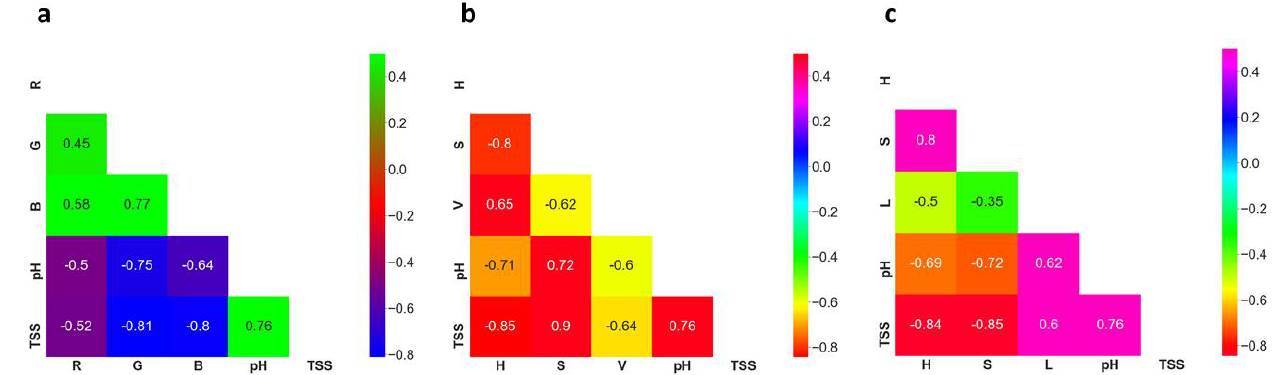
Figure 5. Pearson correlation coefficients for the relationship between predictor and response vari-